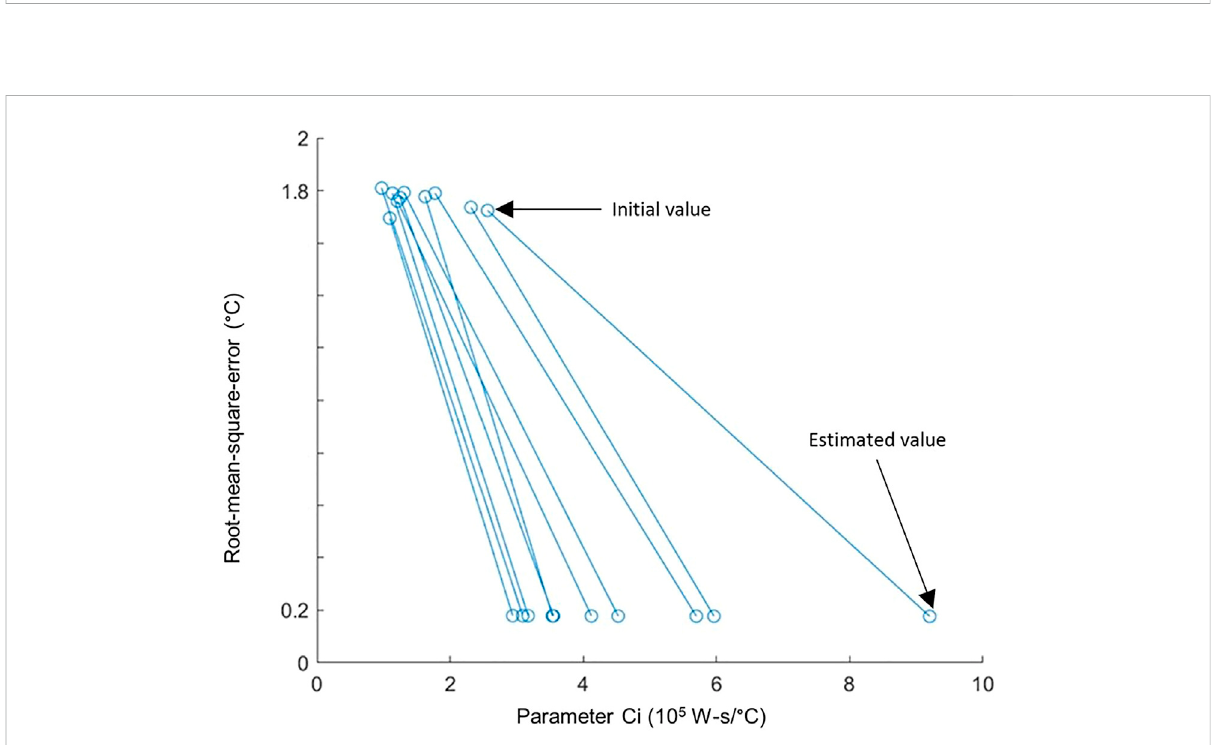
FIGURE 4 Initial vs. estimated values of parameter Ci when training with D1 in network